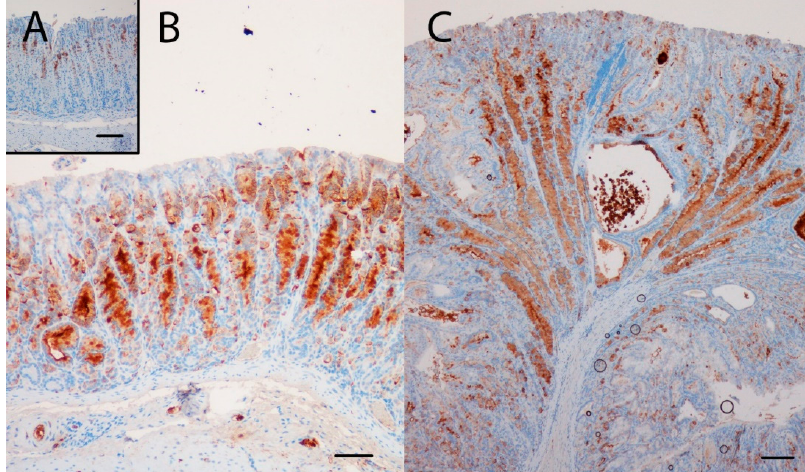
Figure 4. The SPEM marker TFF2 was highly expressed in the oxyntic mucosa of KO/PEG ( C ) and KO/NTZ mice compared to WT/PEG mice ( A ). TFF2 expression in KO mice was not affected by NTZ administration (B). Scare Bar = 100µm.